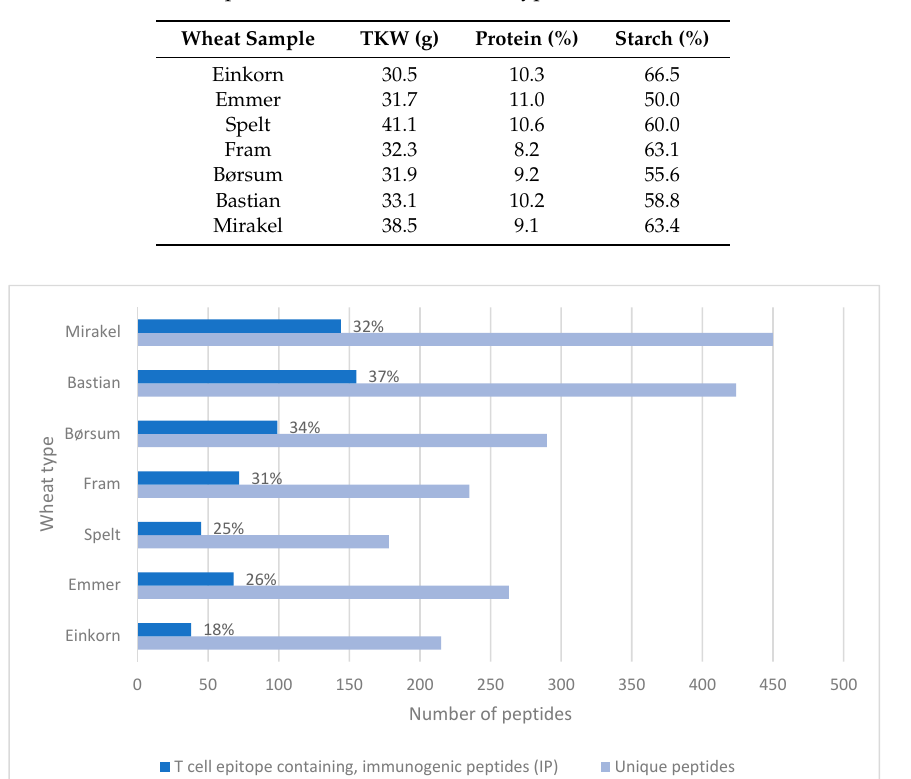
Table 2. Variations in grams per thousand kernel (TKW), starch and proteins among the di ff erent wheat types (einkorn, emmer and spelt) and the common wheat types (Fram, Børsum, Bastian and Mirakel).